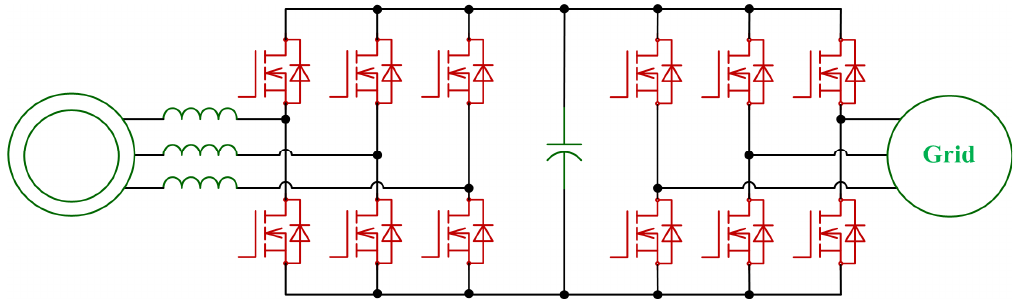
Figure 4. The PWM converter wind generation system.